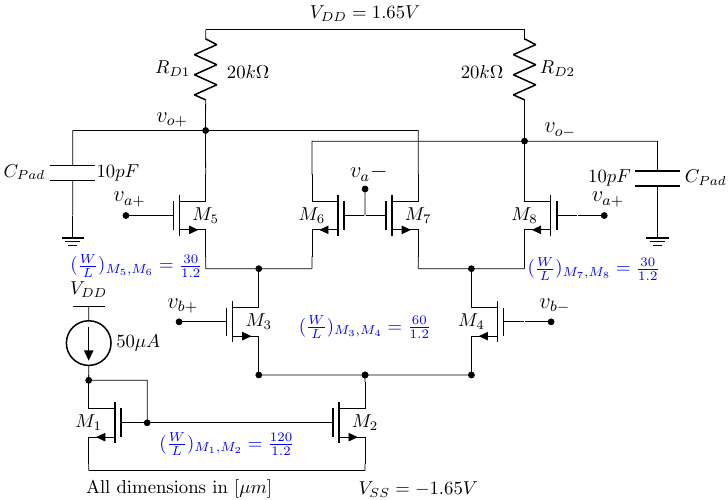
Figure 7. Analog Four-Quadrant Multiplier (MOS Gilbert cell).